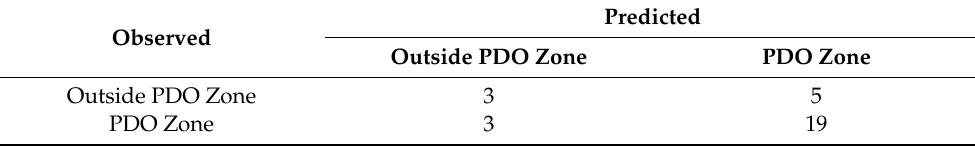
Table 2. Confusion matrix according to the classification analysis.